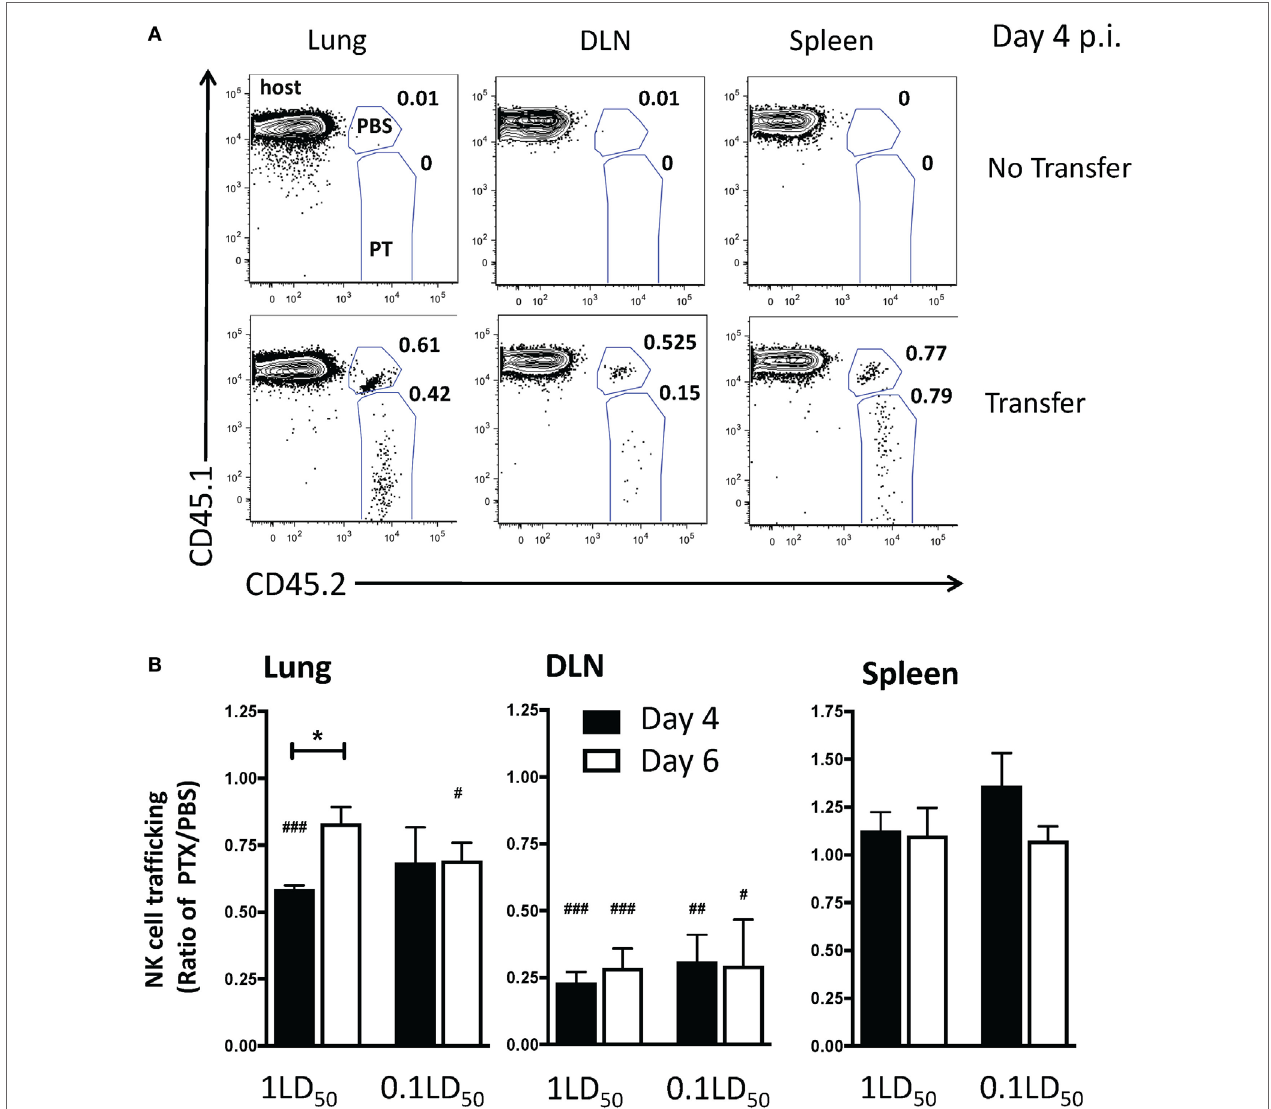
FigUre 4 | Inhibition of chemokine receptor signaling in natural killer (NK) cells results in a decreased accumulation in the lungs and draining lymph nodes (DLNs) of influenza A virus (IAV)-infected mice. C57Bl/6 (CD45.1) host mice were infected with a high- or low-dose of IAV. 1 × 10 5 donor C57Bl/6 NK cells treated with pertussis toxin (PT) (CD45.2 + ) and 1 × 10 5 C57Bl/6 NK cells treated with phosphate buffered saline (PBS) (CD45.1 + CD45.2 + ) were transferred into infected host mice for 16–18 h before analysis (i.e., transferred on day 3 p.i. for day 4 analysis, or day 5 p.i. for day 6 analysis). A group of non-NK cell transferred mice was used as a control. (a) Representative flow plots for NK cells (NK1.1 + CD3 ε − ) on day 4 p.i. in high-dose IAV lungs, DLN, and spleen showing host (CD45.1 + CD45.2 − ), PBS-treated donor (CD45.1 + CD45.2 + ), and PT-treated donor (CD45.1 − CD45.2 + ) NK cells. (B) the normalized ratio of PT-treated NK cells to PBS-treated control NK cells in the lungs, DLN, and spleen of infected recipients is shown. Note: equal trafficking between PBS- and PT-treated NK cells = 1, an increased PT-treated NK cell